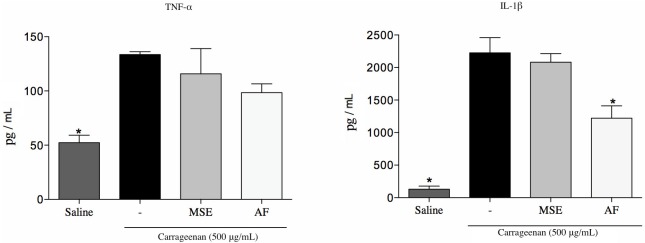
Quantification of TNF-α and IL-1β in the peritoneal cavity.Mice were previously treated with the vehicle, the MSE and the AF at a dose of 30 mg/kg 1h before the carrageenan injection. Data are expressed as mean±SD, n = 6. Symbols indicate statistical difference (p<0.05, Dunnett’s test); *p<0.05 compared to the carrageenan group.